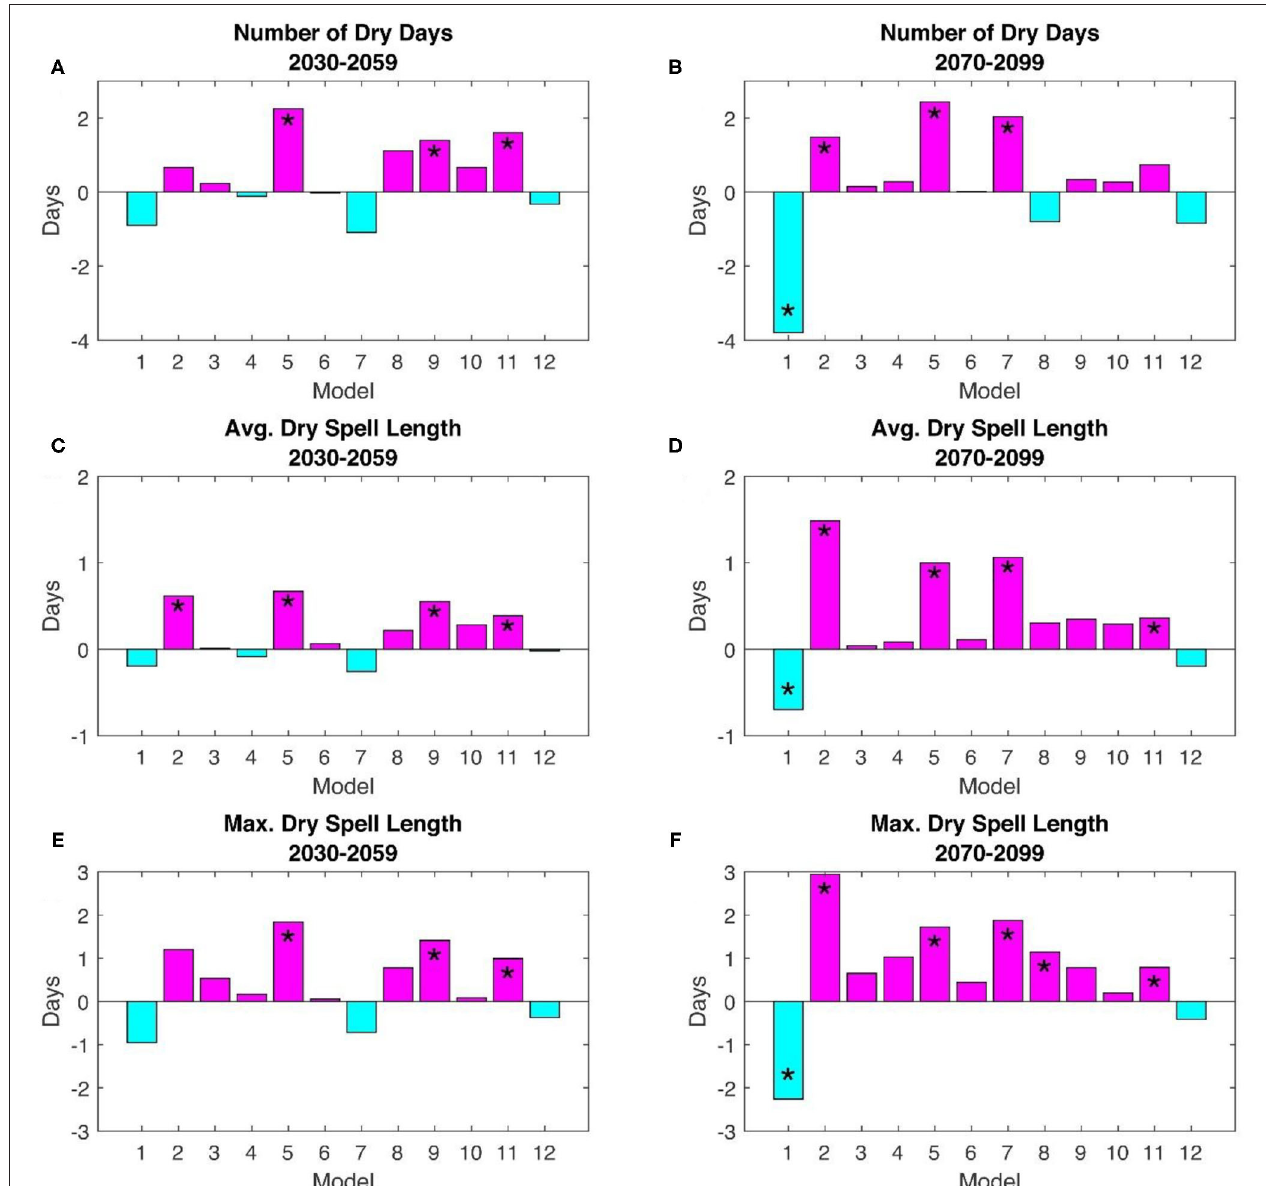
FIGURE 8 | The projected changes in the 30-year, regionally averaged summer climatologies for each NA-CORDEX model in mid- (2030–2059) and late-century (2070–2099), relative to the model historical period (1976–2005). Shown are the number of dry days (A,B) , average dry spell length (C,D) , and the maximum dry spell length (E,F) . Model numbers are the same as in Table 1 . Asterisks indicate models where the regional change was statistically significant at the 5% level.